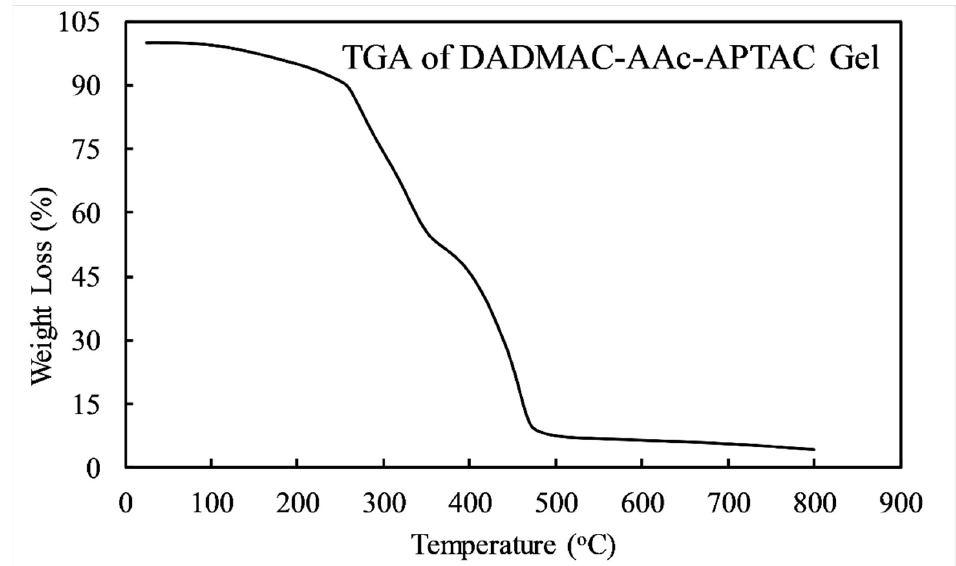
Figure 7. TGA graph of DADMAC-AAc-APTAC gel prepared by 2 kGy radiation dose.